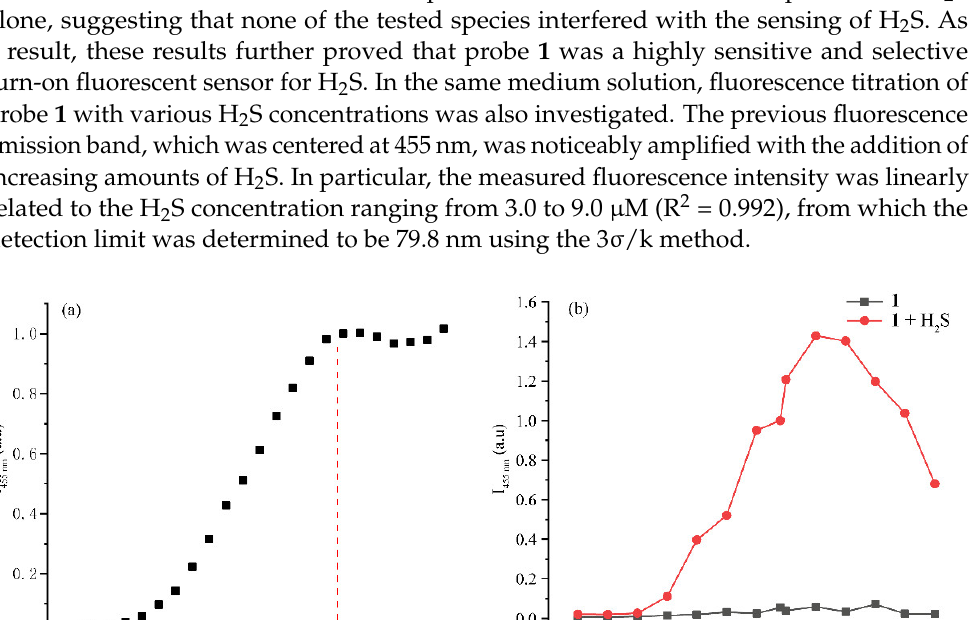
Figure 3. ( a ) Time-dependent fluorescence intensity of 1 at 455 nm in the presence of 10 equiv. of H 2 S in H 2 O-CH 3 CN (1:1, v/v , 10 mM PBS, pH = 7.40) mixed aqueous medium (λ ex = 413 nm, slit = 10 nm/10 nm). ( b ) pH-dependent fluorescence intensity of 1 at 455 nm followed by the addition of 10 equiv. of H 2 S in H 2 O-CH 3 CN (sodium hydroxide and hydrochloric acid were used to modulate the pH values).